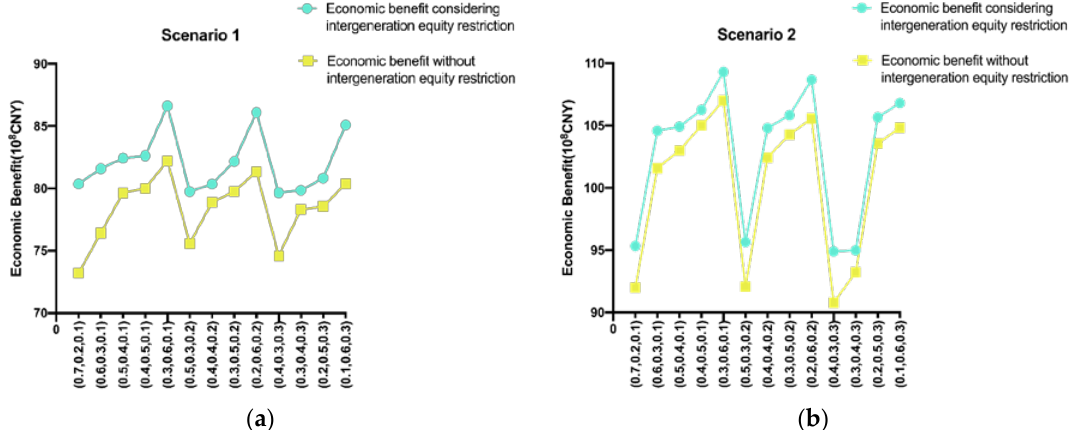
Figure 7. Comparison of economic benefits that do and do not consider intergeneration equity restriction (( a ) 2020, ( b ) 2050, (0.7 0.2 0.1) means ω 1 = 0.7, ω 2 = 0.2, ω 3 =